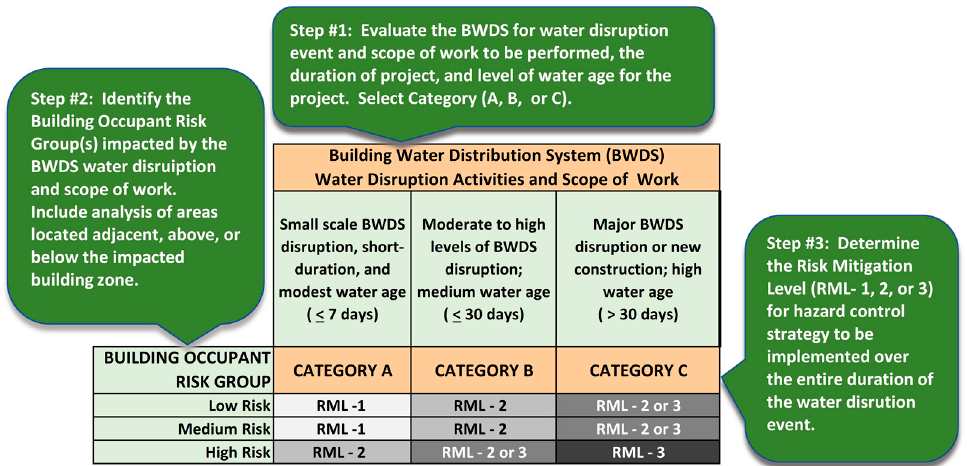
Figure 3. WQSRA risk decision matrix. Adapted with permission from Ref. [50]. 2022, Scanlon et al. (CC BY 4.0).